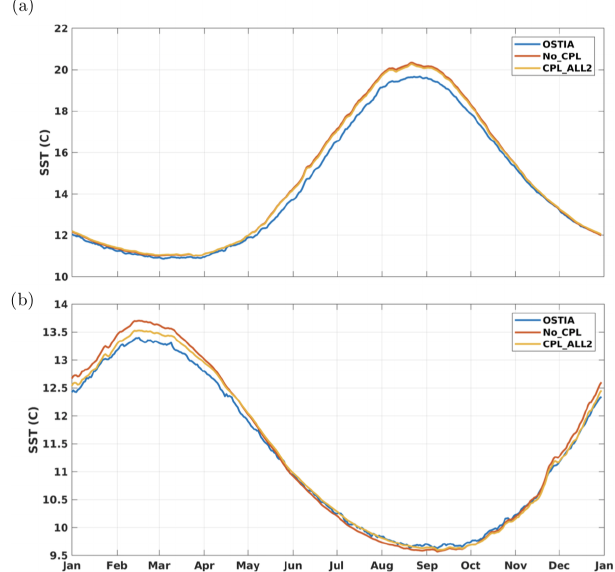
Figure 12. Time series of the spatially averaged sea surface temper- ature ( ◦ C); (a) Northern Hemisphere and (b) Southern